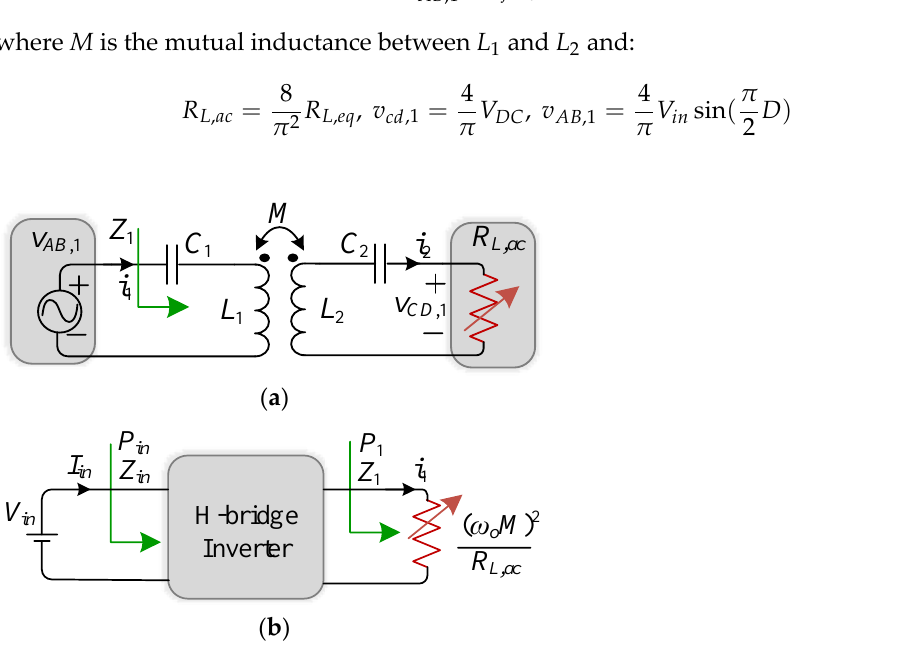
Figure 5. ( a ) WPTS model with the fundamental approximation ( b ) Load seen from the inverter output terminals.